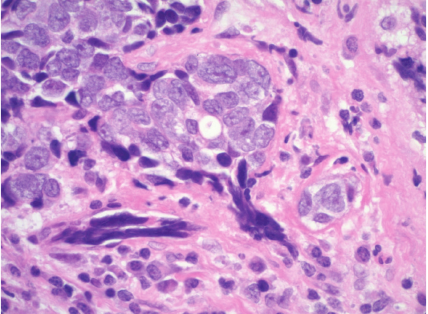
Figure 2: Tissue section from the nasopharyngeal biopsy showed a nested histoarchitecture with crush artifact and a well-preserved region of lesional cells set in a fibrous stroma with accompany- ing lymphocytes and plasmacytoid cells. Tumor cell sizes were intermediate to large with minimal to moderate amounts of amphophilic cytoplasm, large nuclei with finely granular chromatin, and eosinophilic nucleoli (hematoxylin and eosin stain, 600x).